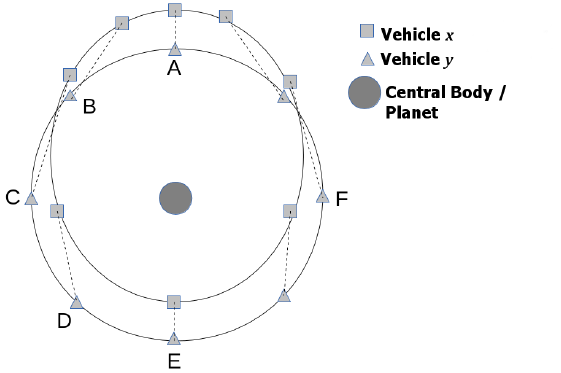
Figure 1. Schematic of the conceptual 1:0:1 resonance. The solid lines represent the path through the inertial frame for two different orbits. The dashed lines indicate the relative position of the two vehicles at snapshots in